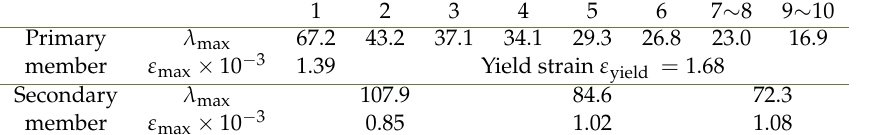
Table 7. Maximum slenderness ratio λ max and buckling strain E max of the triangular tower